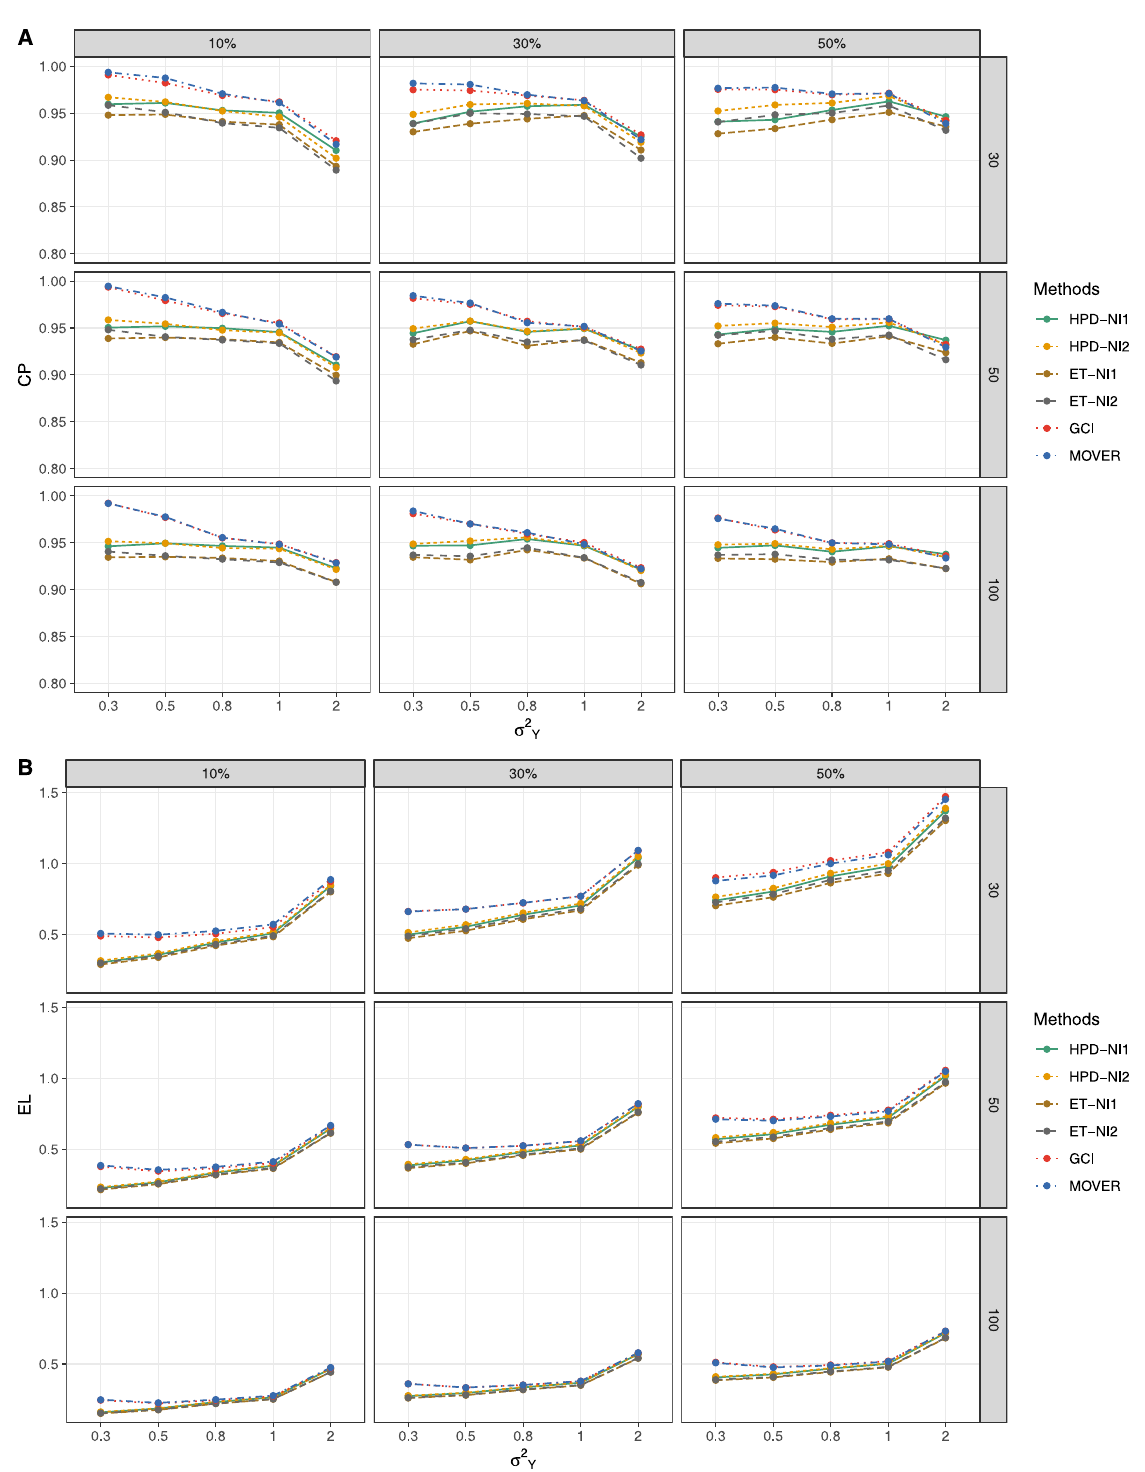
Fig 3. Performance measures of 95%CIs for θ : a = 15 (A) Coverage probabilities and (B) Expected lengths.